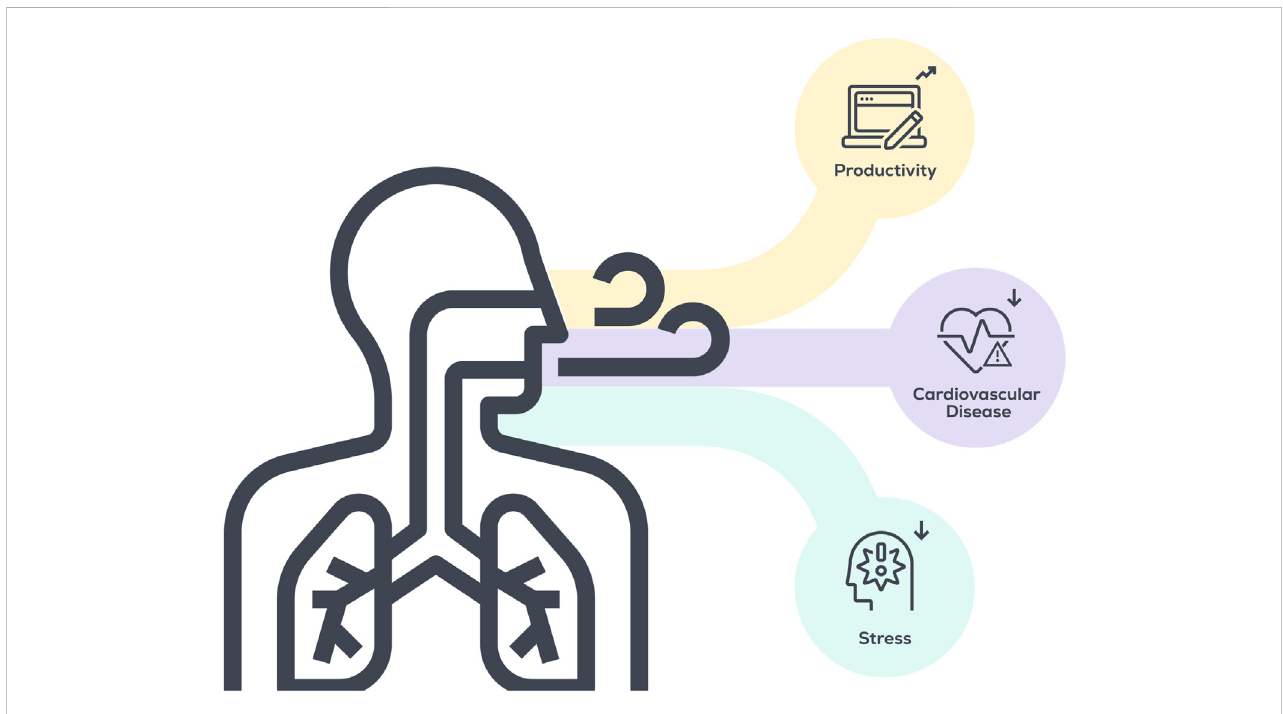
FIGURE 1 Potential bene fi ts of implementing DBE in the